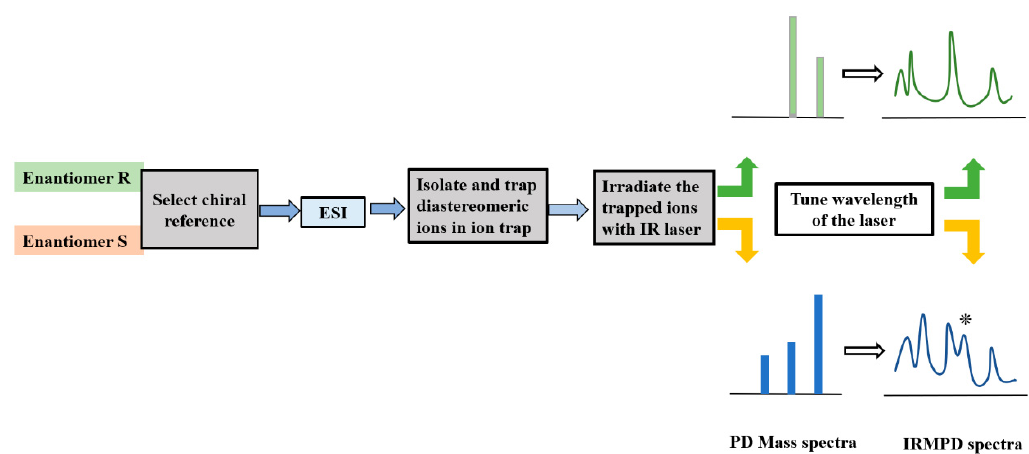
Figure 1. A typical schematic diagram to show the application of infrared multiple photon dissociation (IRMPD) spectroscopy in chiral analysis.